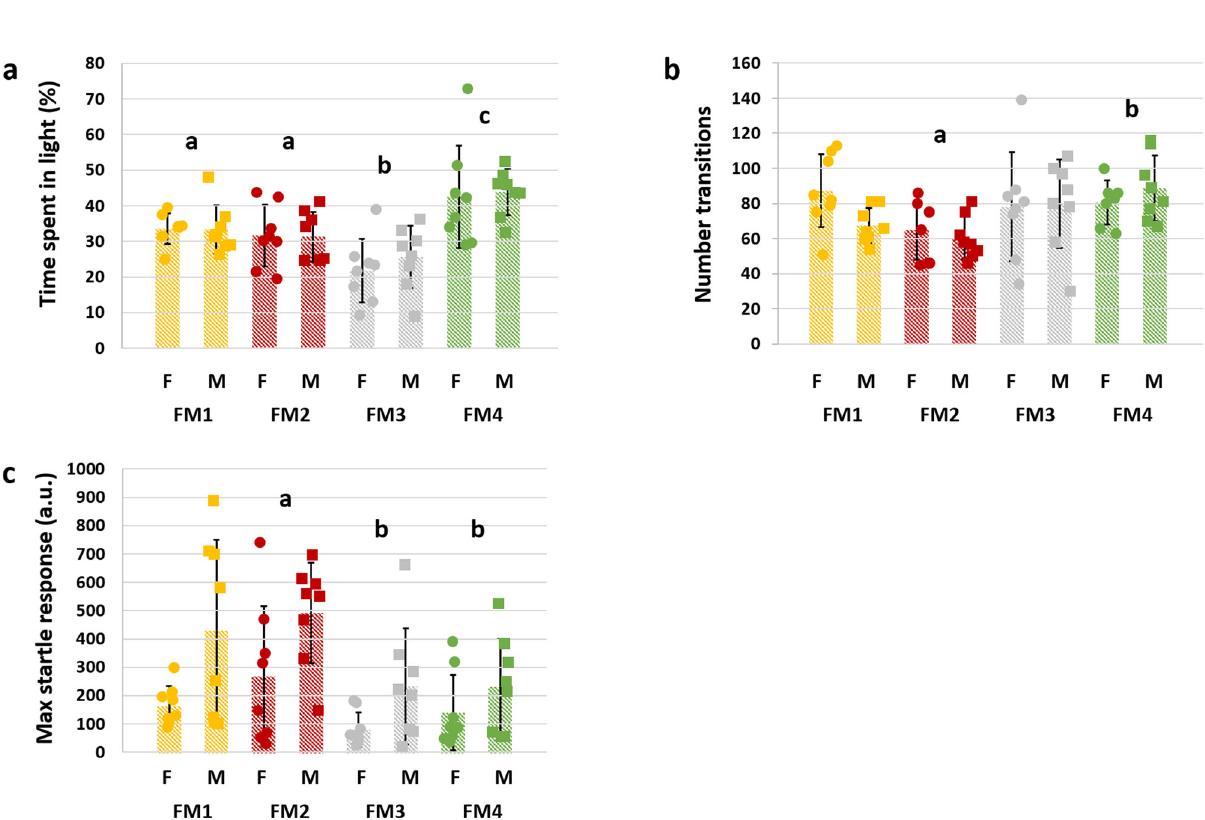
Table showing p and F values associated with main effects of Sex and FM, the directionality of post hoc comparisons between male (M) and female (F) and the four fecal microbiotas (FM1 – FM4), and interactions.